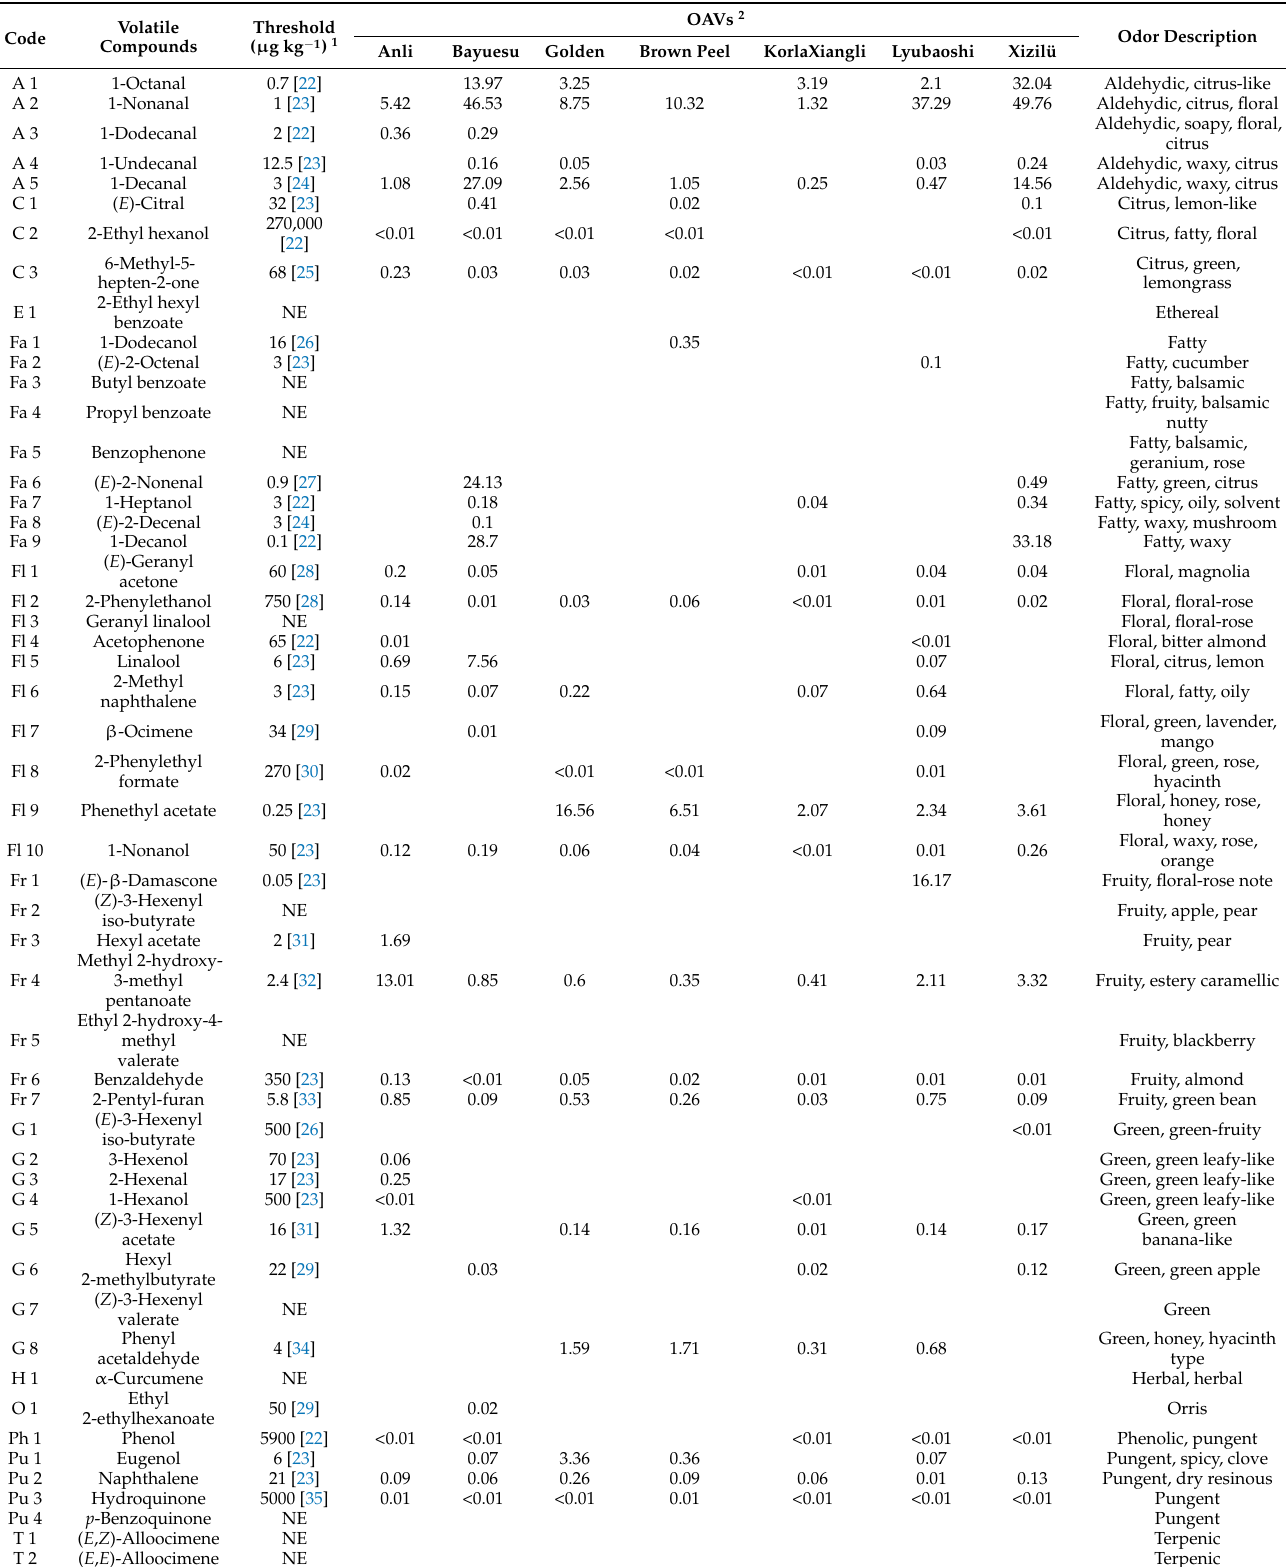
Table 3. Odor thresholds in water, odor descriptions, and OAVs of the studied aroma volatiles determined in pear